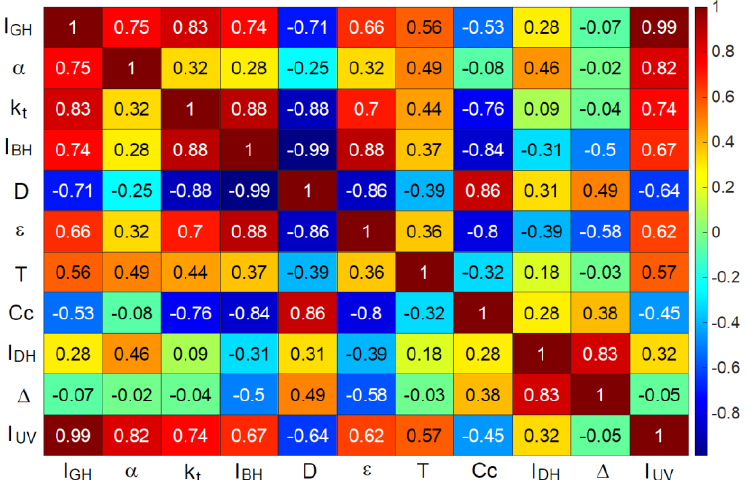
Figure 2. The Pearson correlation coefficient matrix of all meteorological variables considered in this study.